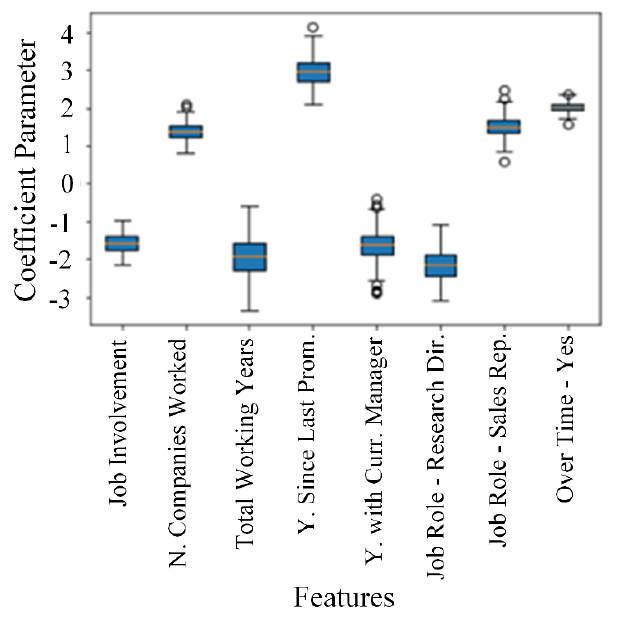
Figure 7. Confidence level visualization for the most influential coefficients.